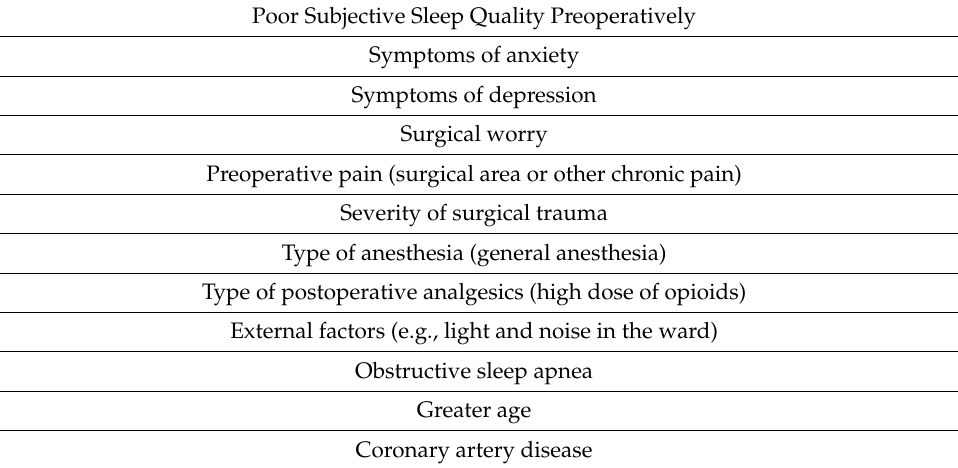
Table 1. Factors known to associate with poor postoperative sleep, and which are important to consider during the perioperative